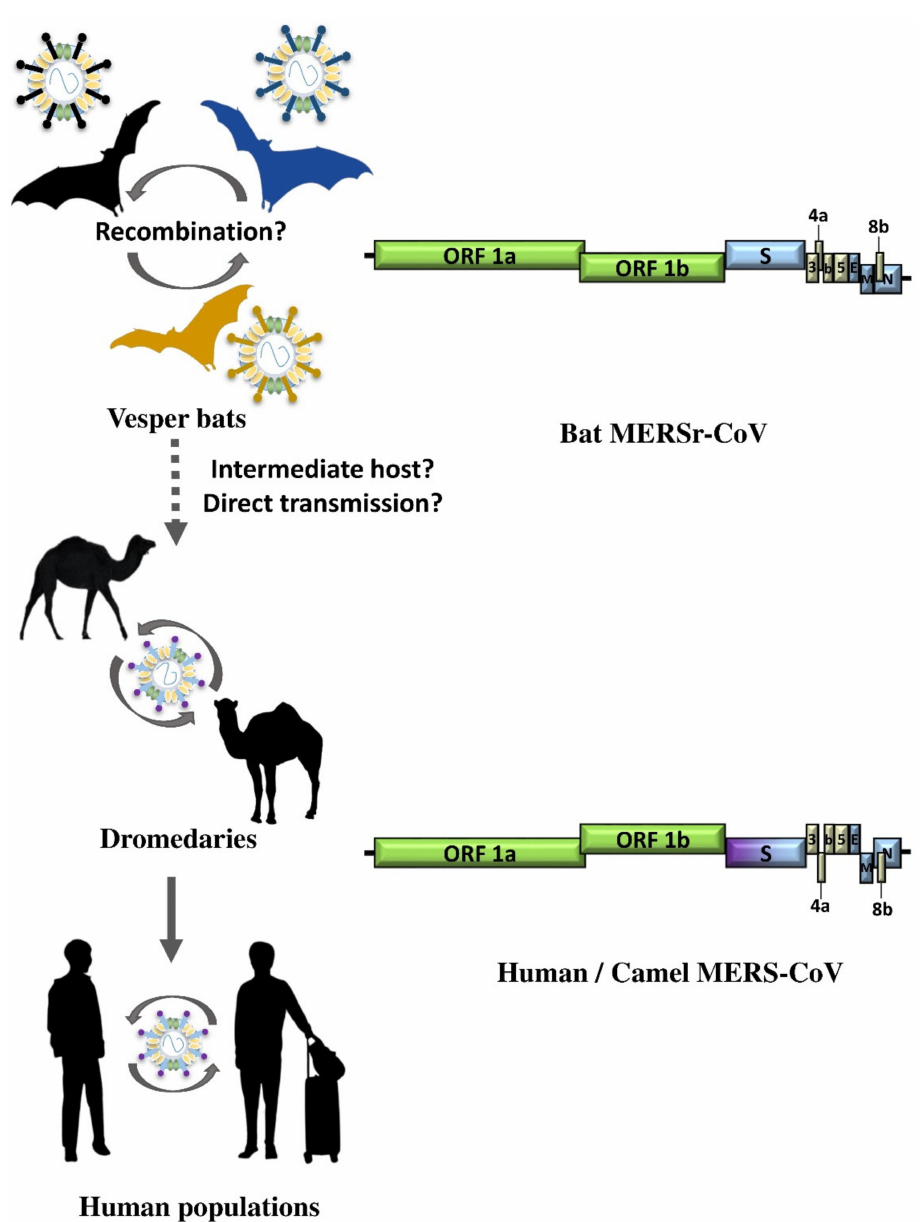
Figure 3. Overview of interspecies transmission events of MERS epidemic since 2012. Arrows indicate the direction of viral interspecies jumping between different host species. Circular arrows indicate the circulation of virus within the population. Dot arrows indicate the viral interspecies jumping event remains to be elucidated. ORF1a and ORF1b are represented by green boxes, structural proteins by blue and purple boxes, and accessory proteins by yellow